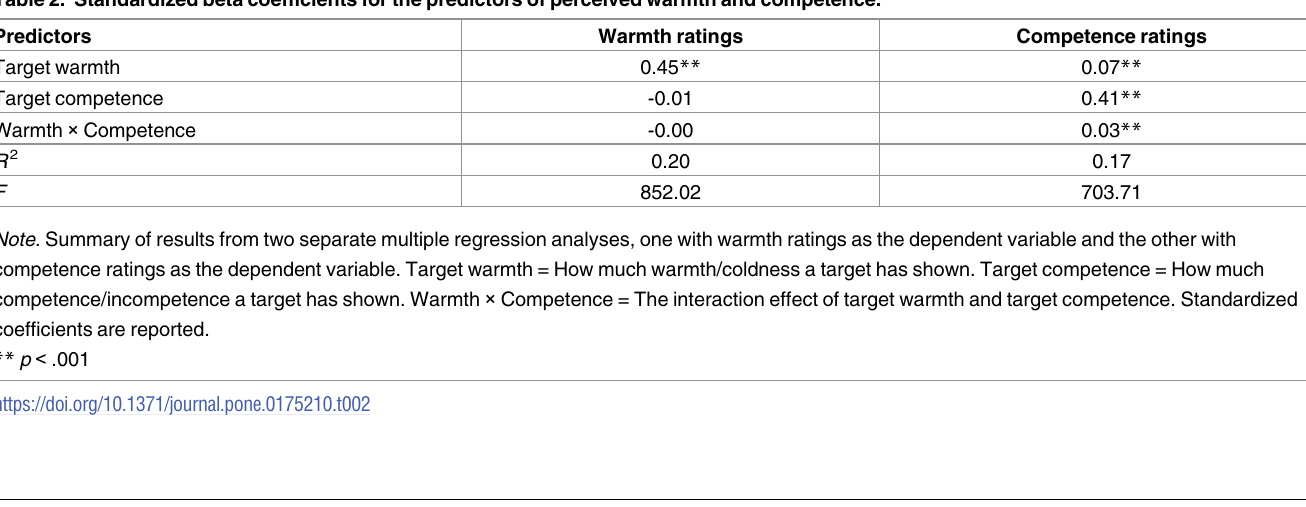
mean change = 17.96, SD = 9.91, t (71) = 15.37, p < .001, and cold targets as more cold on the last than the first rating; mean change = 12.91, SD = 15.29, t (71) = 7.16, p < .001. The mean dif- ference between the first and the last ratings were significantly larger for the warm than for the cold targets; t (71) = 3.05, p = .003. Similar analyses were conducted for the competence ratings, where behavior along the competence dimension influenced competence ratings (Table 2). In addition, warmth ratings influenced competence ratings, in that warm targets were rated as more competent. Also, the developed warmth × developed competence interaction effect was significant. The interaction revealed that warmth influenced competence ratings the most when the target was competent, so that targets that were both warm and competent were rated as most competent. Competent targets were rated as more competent on the last compared to the first trial; M = 9.92, Diff SD = 12.54, t (71) = 6.70, p < .001, and incompetent targets as more incompetent on the last